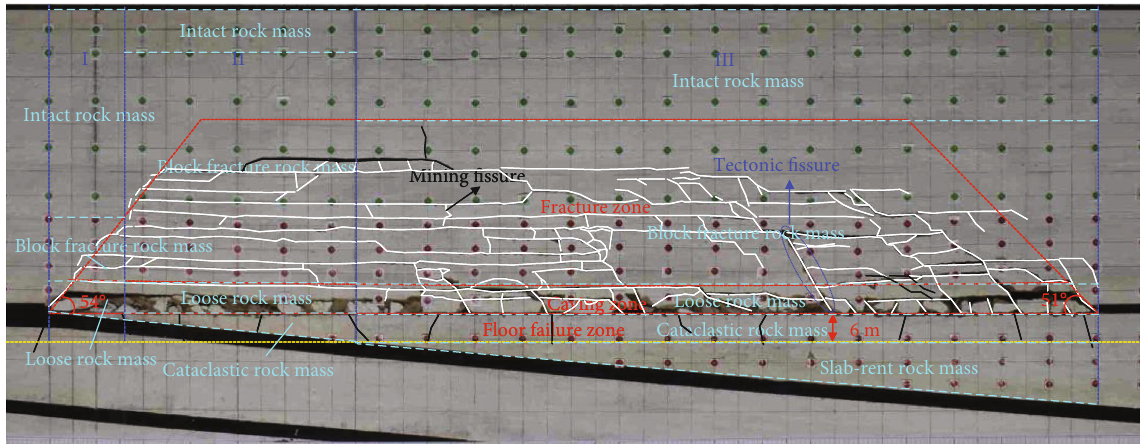
Figure 11: Schematic diagram of overburden structure division due to the mining in fl uence.